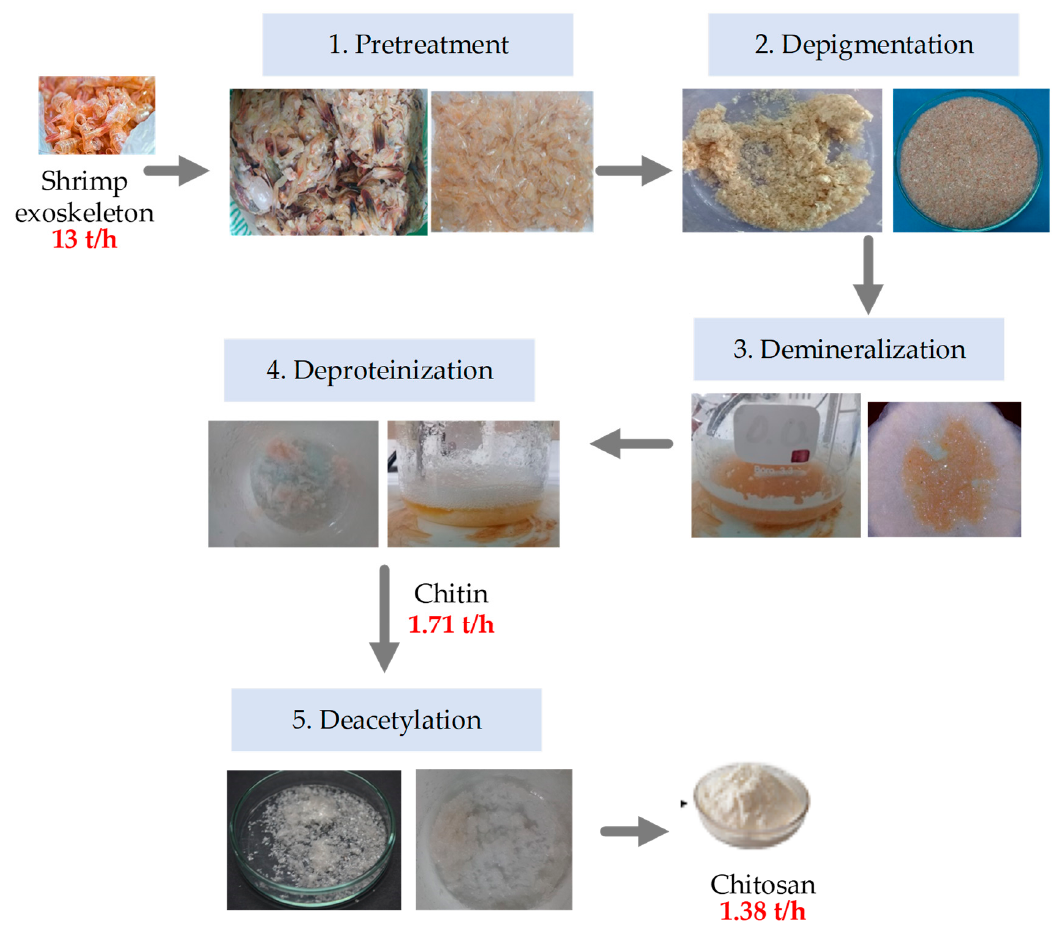
Figure 2. Process diagram for chitosan production from shrimp exoskeleton.